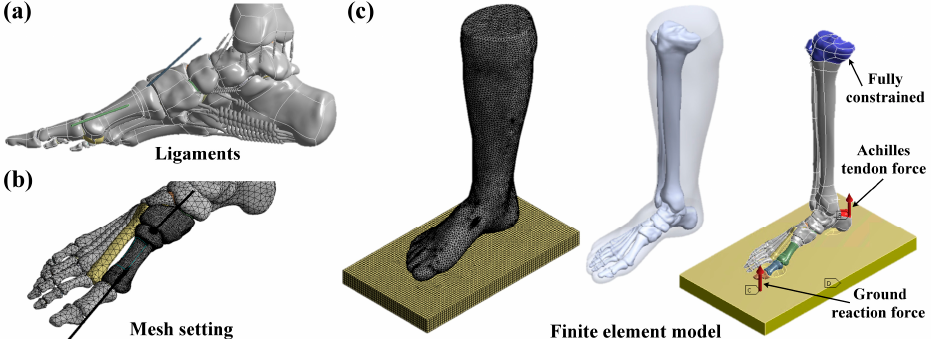
Figure 4. ( a ) The foot ligaments of the numerical model; ( b ) the mesh setting of the foot model with the osteotomy and Kirschner wire fixation; and ( c ) the finite element model of the foot with the loading and boundary conditions.